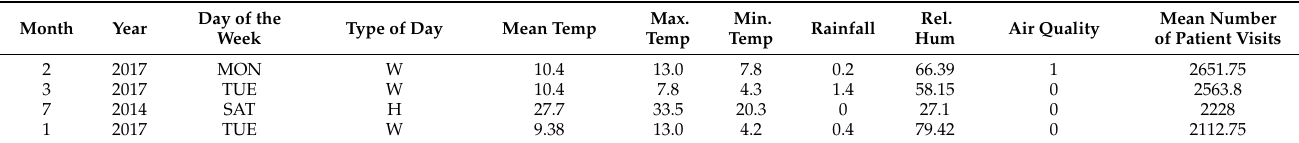
Table 1. An example of training